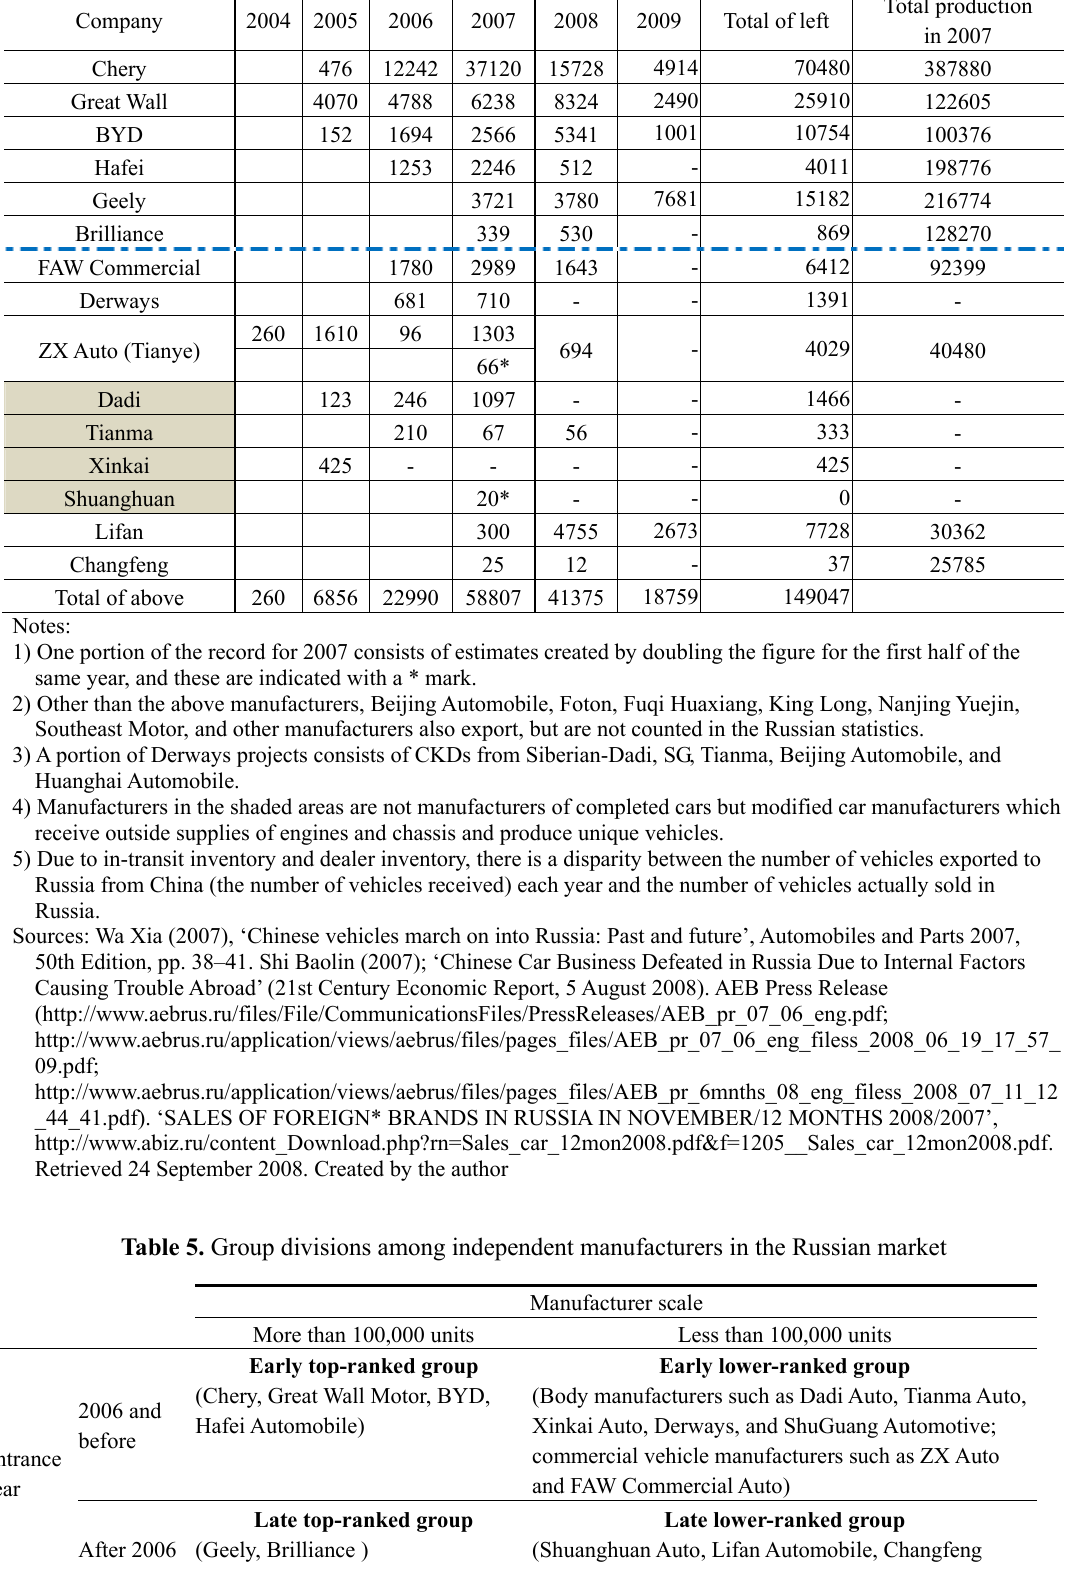
Table 4. Sales records for Chinese cars in the Russian market (unit: vehicles) Company